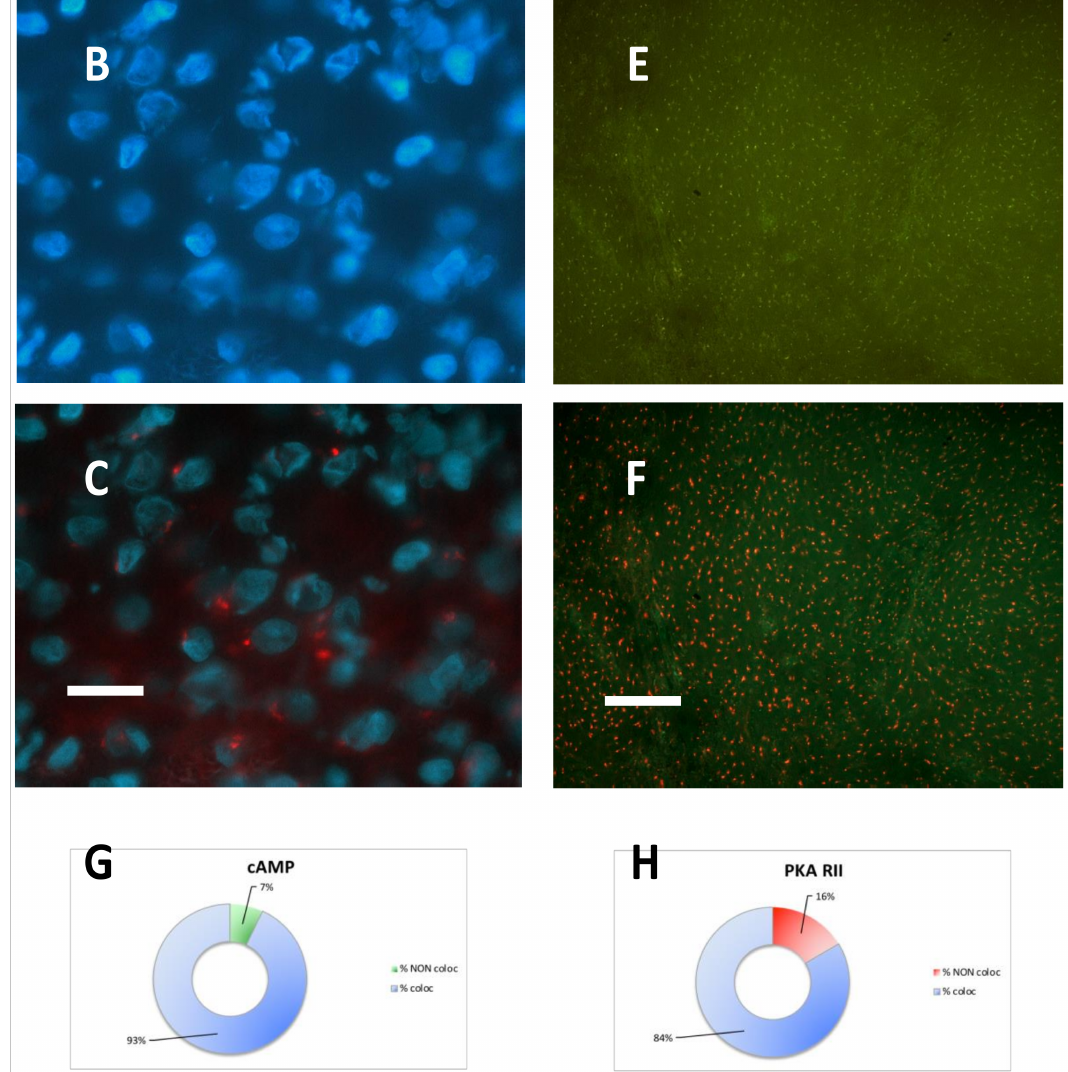
Figure 2. Case 3 representative images. ( A ) PKA RII immunofluorescence. ( B ) Same field, DAPI nuclear counterstaining. ( C ) Merging of ( A ) and ( B ). ( D ) Low power image of PKA RII immunofluorescence. ( E ) Same field, SAF-cAMP labelling. ( F ) Merging of ( D ) and ( E ); the orange color indicates coincidence oftheredandgreensignals. ( G )Percentageofcolocalization(blue)ornon-colocalization(green)ofcAMP with PKA RII, relative to Figure 2 ( F ). ( H ) Percentage of colocalization (blue) or non-colocalization (red) of PKA RII with cAMP, relative to Figure 2 ( F ). ( A – C ): 100x objective, bar = 10 µ m. ( D – F ): 20x objective, bar = 50 µ m. Unaltered